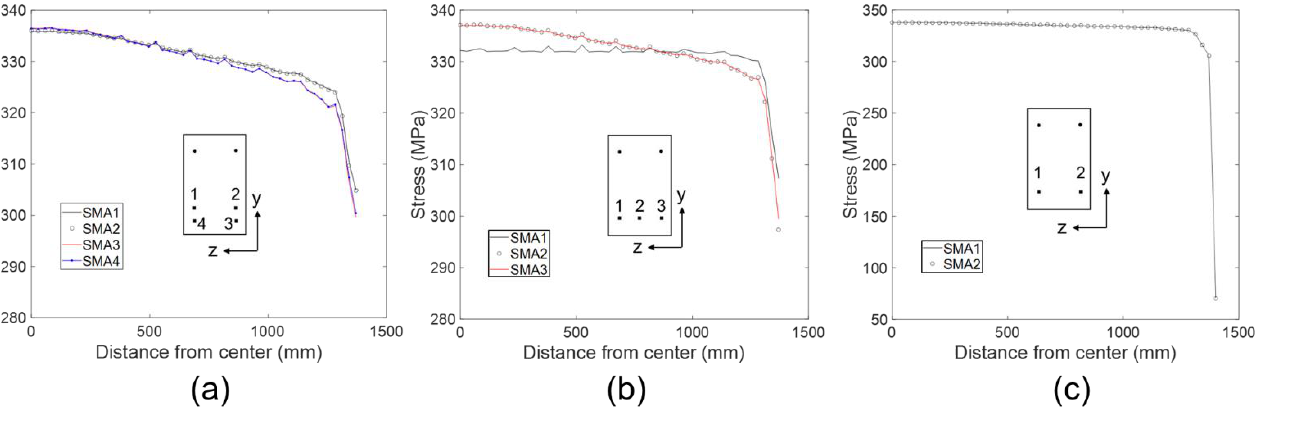
Figure 13. Normal x -axis stress distributions along Fe-SMA bars after activation, calculated by FE simulations with various numbers of Fe-SMA bars. ( a ) With 4 Fe-SMA bars, ( b ) with 3 Fe-SMA bars and ( c ) with 2 Fe-SMA bars.